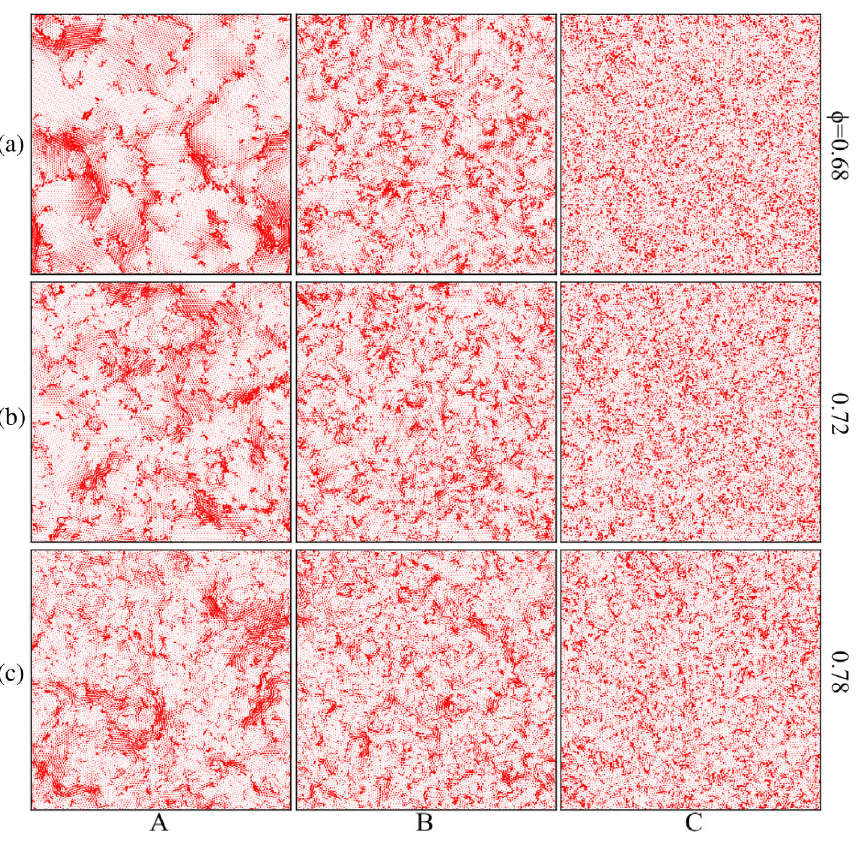
ffiffiffiffiffiffiffiffiffiffiffiffiffiffiffiffiffi p U 0 =m σ 2 ¼ 1 . 0 (A), 5.5 (B), and 13.5 (C) for ϕ ¼ 0 . 68 (a), 0.72 (b),